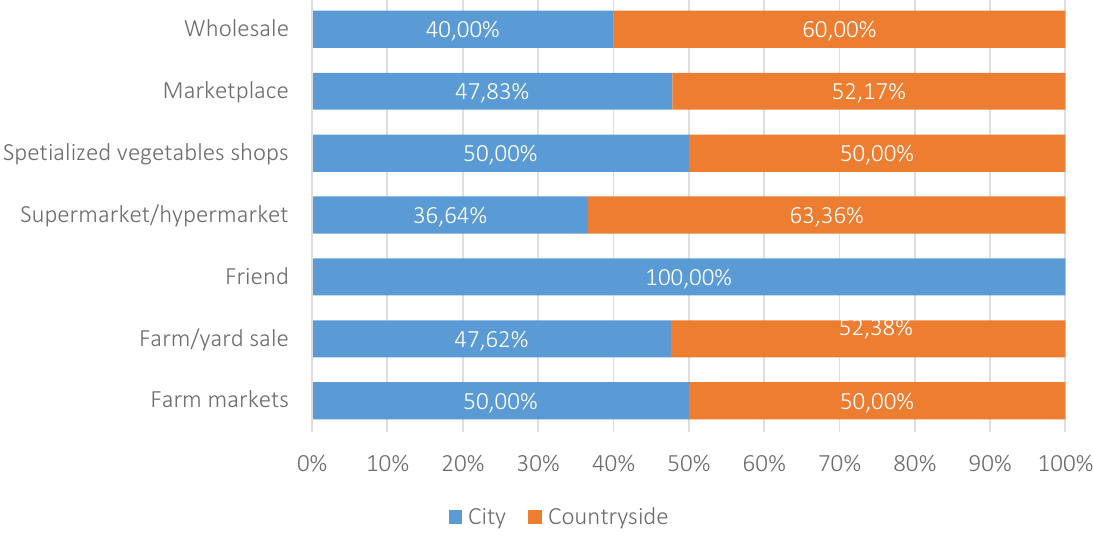
Figure 4. Place of residence and place of tomato